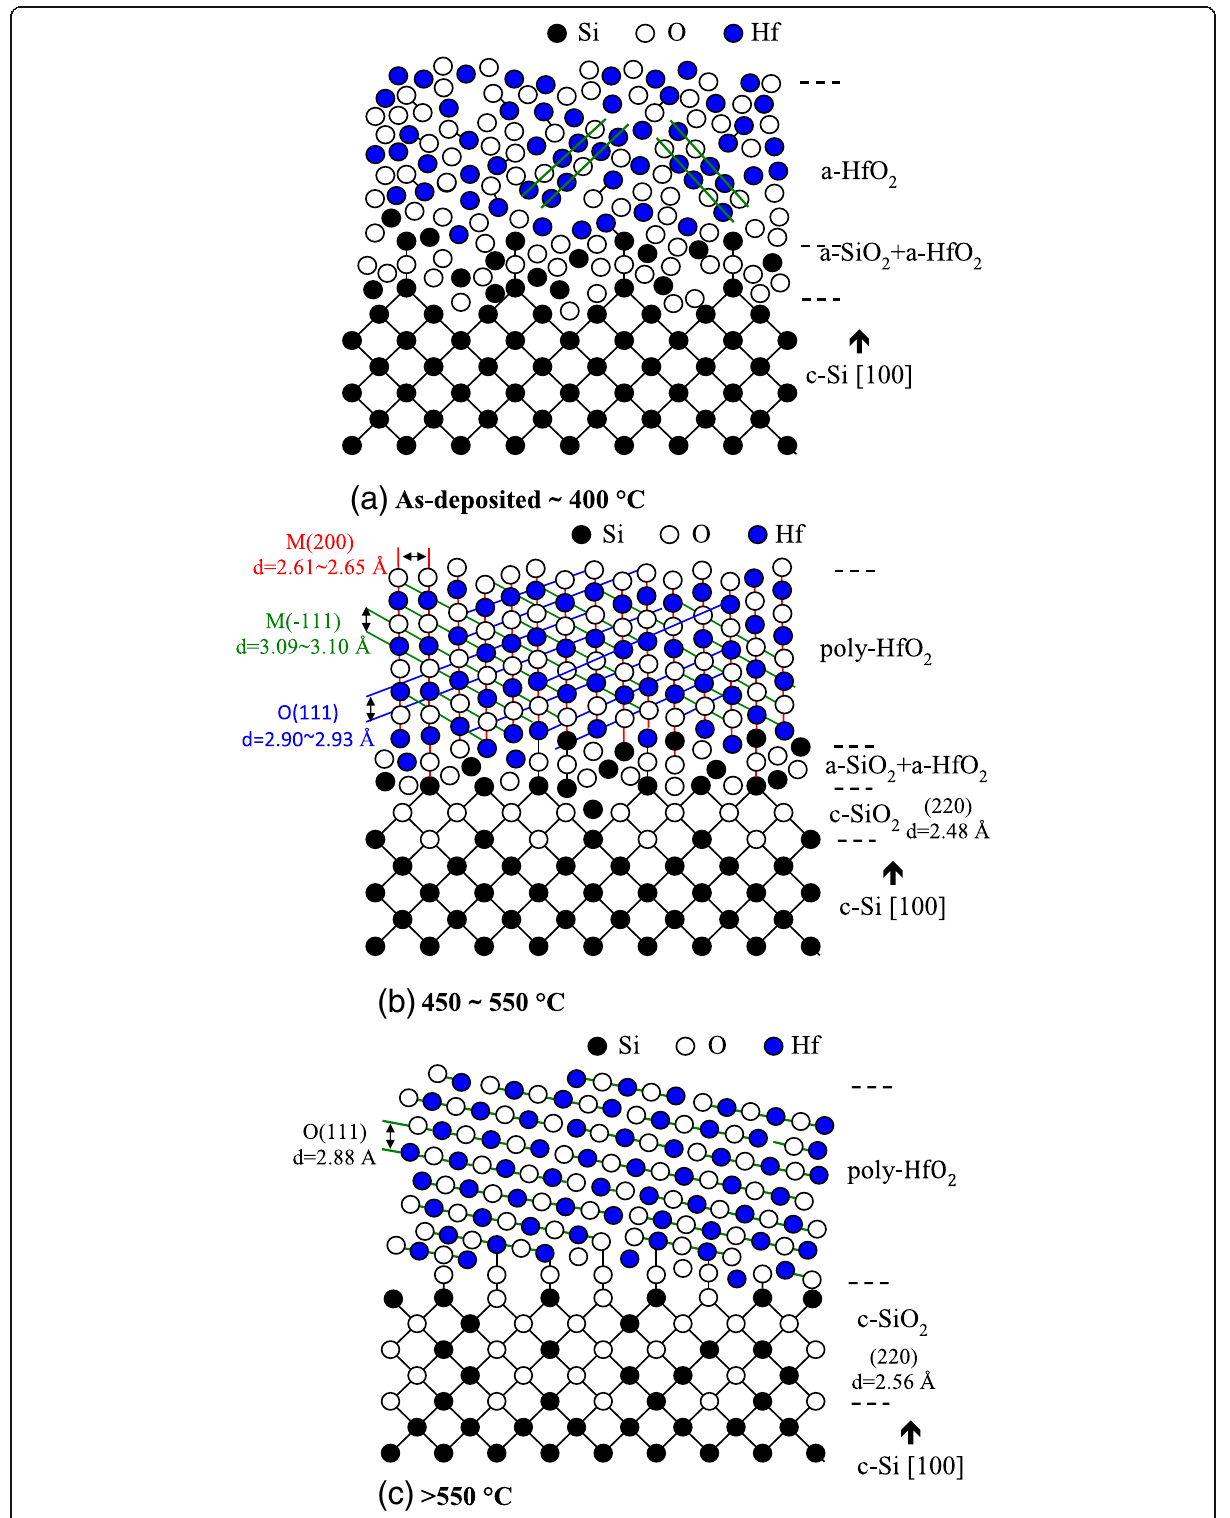
Fig. 5 Diagrams of mechanism of crystallization of HfO 2 films and interfacial layer in the temperature ranges a as-deposited to 400 °C, b 450 to 550 °C, and c beyond 550 °C. The d-spacing value and crystalline orientation are also